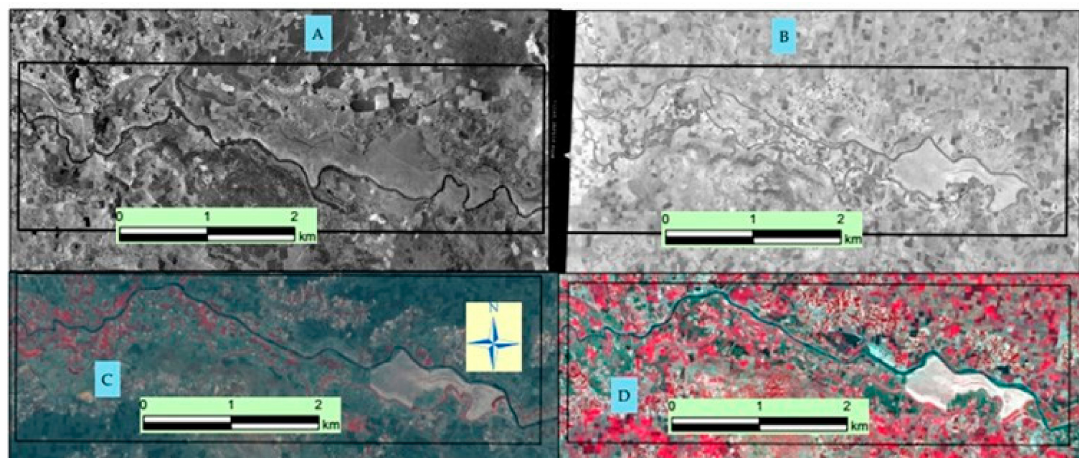
Figure 15. Aerial photographs and SPOT satellite images of the Middle river section downstream of the weir. ( A , B ) aerial photograph and river pattern of the year 1957 and 1980, respectively, and ( C , D ) SPOT satellite image and river pattern of the year 2006 and 2012, respectively.